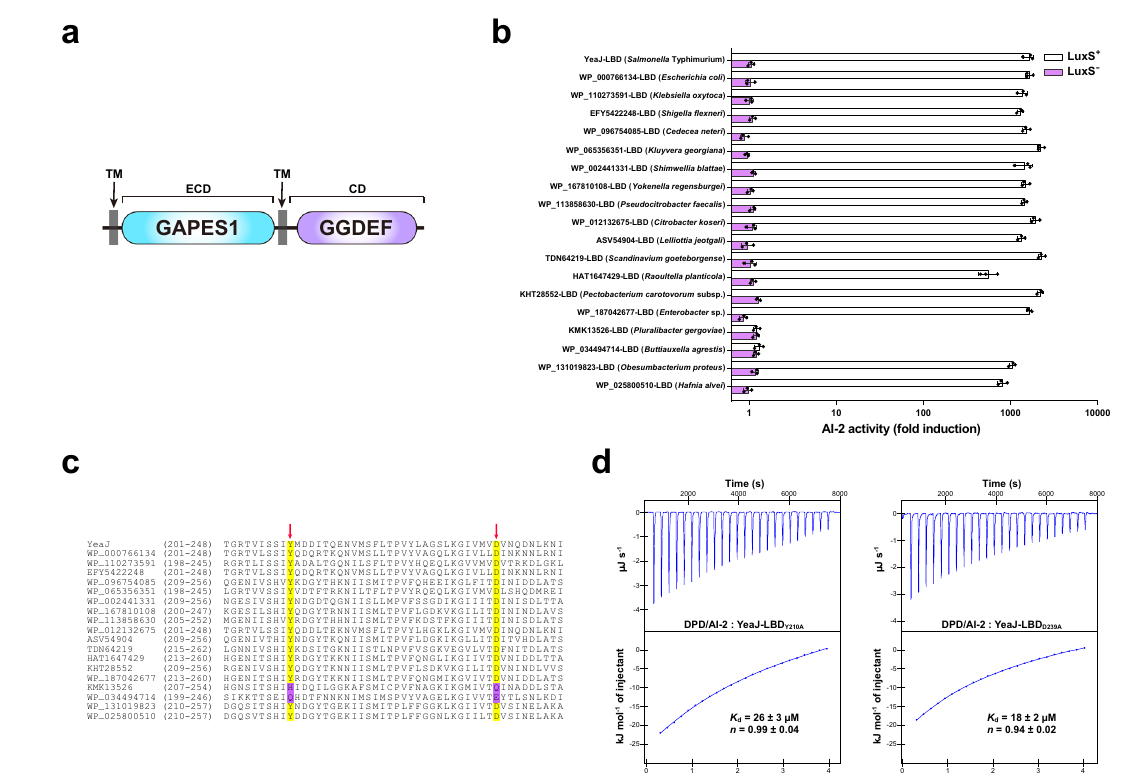
bacterial species to which they belong are given in parentheses. c AI-2-binding GAPES1 domains of YeaJ homologs harbor two conserved residues corresponding toY210andD239ofYeaJ.GAPES1domainsofYeaJanditshomologsthathavebeen tested for AI-2 binding activity were aligned using ClustalW embedded in MEGA7 software. Two positions corresponding to Y210 and D239 of YeaJ that may be involved in AI-2 binding are labeled with red arrows. The conserved residues in the two positions are highlighted in yellow and non-conserved residues are high- lighted in purple. The NCBI accession number for each YeaJ homolog is included. d Isotherms representing binding of two mutants of YeaJ-LBD (Y210A or D239A) withDPD/AI-2.Thebindingaf fi nitywasdeterminedusingITC.Thedatashownwere one representative of three independent experiments with similar results. The K d and complex stoichiometry ( n ) are presented as mean±s.d. of three independent experiments. Source data are provided as a Source Data fi